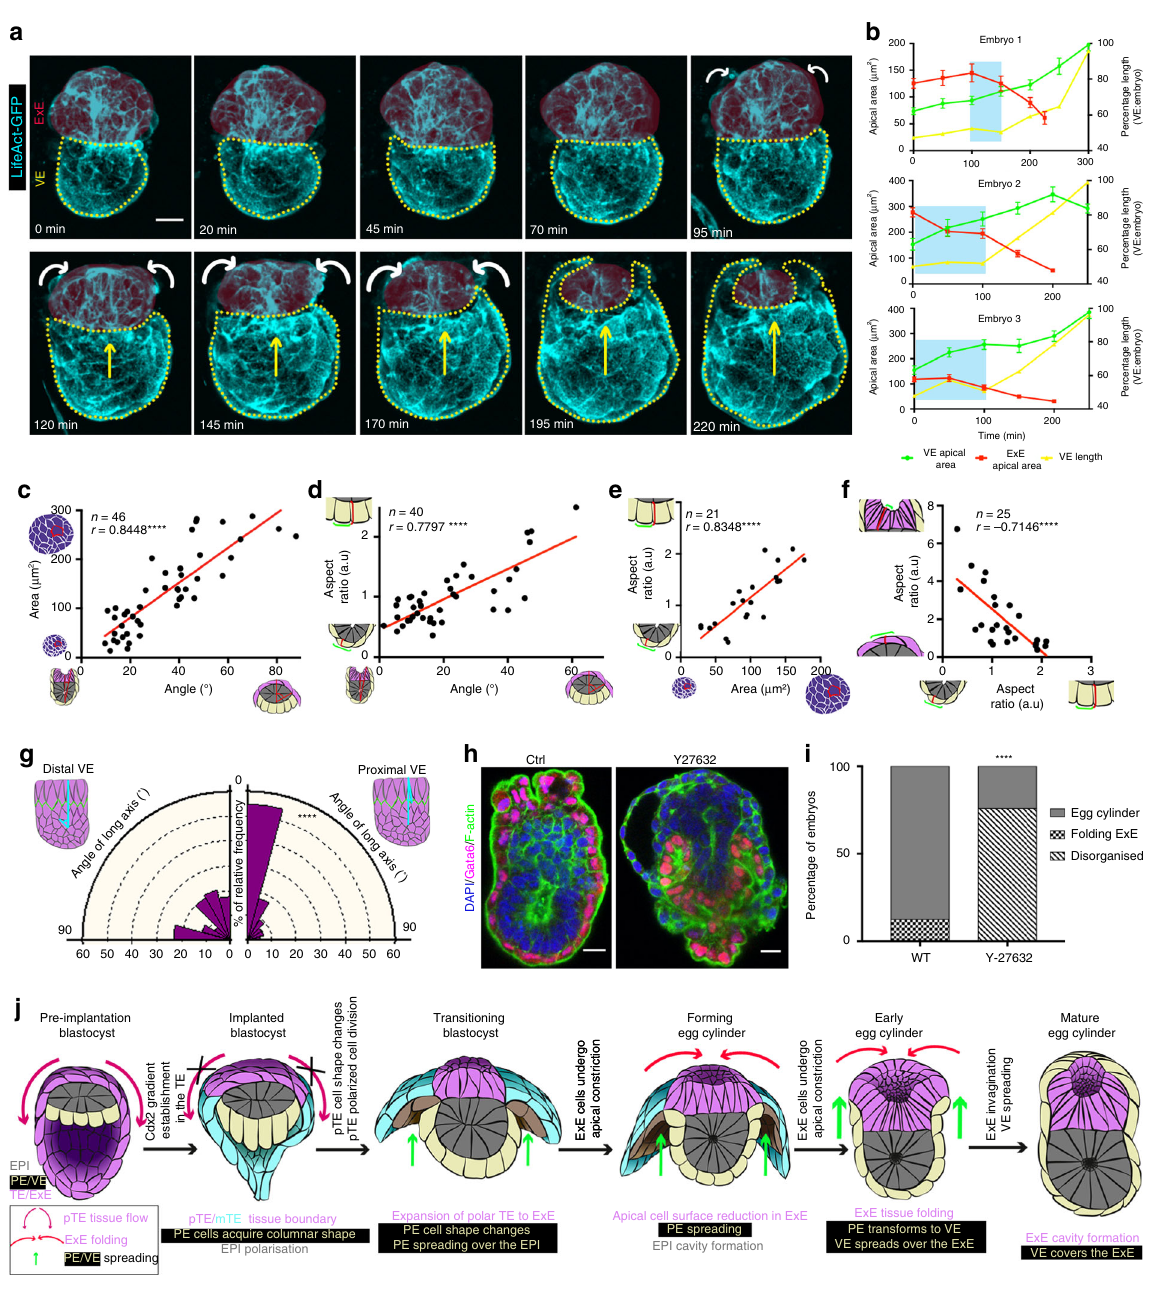
Fig. 6 Trophectoderm folding orchestrates the fi nal step the blastocyst to egg cylinder transformation. a Stills from a time lapse movie of Lifeact-GFP blastocyst. ExE tissue (red) folding (white arrows) through apical constriction is followed by spreading (yellow arrows) of the visceral endoderm (VE) (yellow outline) and formation of egg cylinder. Stills without coloured overlay are presented in Supplementary Fig. 10a. b Quanti fi cation of ExE apical cell surface area, VE apical cell surface area and VE length through time during blastocyst to egg cylinder transformation from three individual embryos shown in Supplementary Movie 8. Cyan boxes indicate the developmental period, during which ExE cell ’ s apical constriction precedes VE spreading. VE tissue spreading during egg cylinder formation is owing to cell-shape changes as quanti fi ed in Fig. 5b. c Quanti fi cation of polar TE/ExE apical cell surface area relative to PE/VE position. d Quanti fi cation of PE/VE cell aspect ratio relative to PE/VE position. e Quanti fi cation of PE/VE cell aspect ratio relative to polar TE/ExE apical cell surface area. f Quanti fi cation of polar TE/ExE cell aspect ratio relative to PE/VE cell aspect ratio. For c – f , Pearson correlation test was used, **** p < 0.0001. g Rose diagram for quanti fi cation of long cell axis orientation in distal and proximal VE at the early egg cylinder stage. Kolmogorov – Smirnov test: **** p < 0.0001. Distal VE: n = 153 cells, Proximal VE: n = 75 cells. h Representative examples of control and Y27632 (ROCK inhibitor)-treated embryos. Embryos were recovered at E4.75 and cultured ex vivo for 12 hours. In the absence of actomyosin contractility (Y27632) egg cylinder formation fails due to defective ExE folding (Supplementary Movie 10). i Quanti fi cation of blastocyst to egg cylinder transformation ef fi ciency in control, and Y27632 treated embryos. χ 2 test; **** P < 0.0001. For h and i n = 16 control and 29 Y27632-treated embryos. j Model of blastocyst to egg cylinder transformation as a result of TE morphogenesis. Source data are provided as a Source Data fi le. Scale bars = 20 µ m